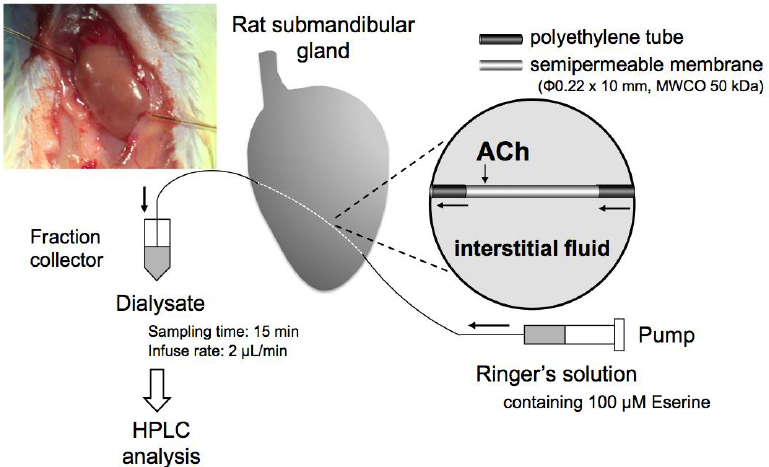
Figure 1. A diagram of the dialysis technique in the submandibular gland. The dialysis probes were perfused with Ringer’s solution containing Eserine (100 µM) using a micro-syringe